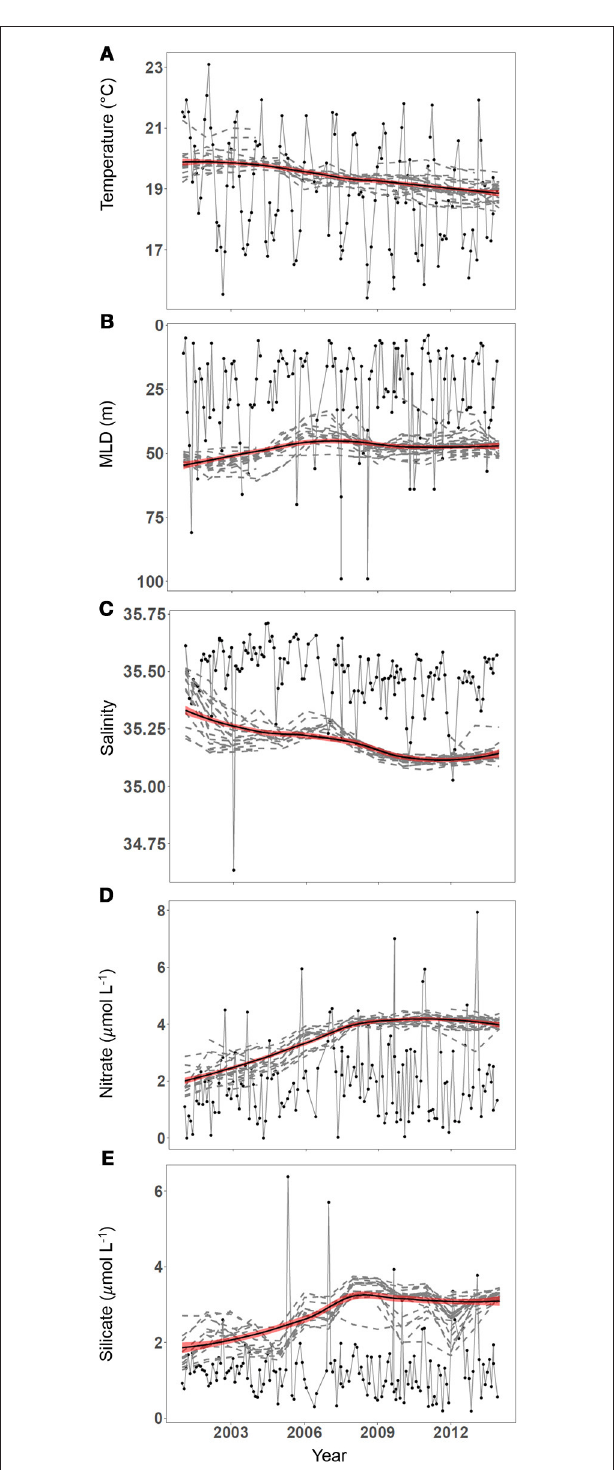
FIGURE 3 | Mean realized niches change over time in response to changes in mean environmental conditions and their distributions. Running mean niches are compared to environmental conditions in panels (A–E) . Monthly environmental conditions are shown (black line, filled circles)for (A) temperature( ◦ C), (B) mixedlayerdepth(m), (C) salinity, (D) nitrate